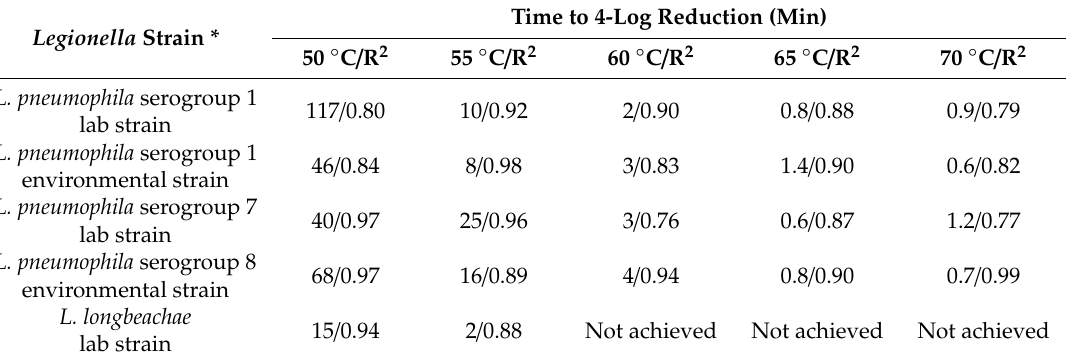
Table 6. Amount of time to 4-log reduction in various Legionella strains at di ff erent temperatures. Adapted from